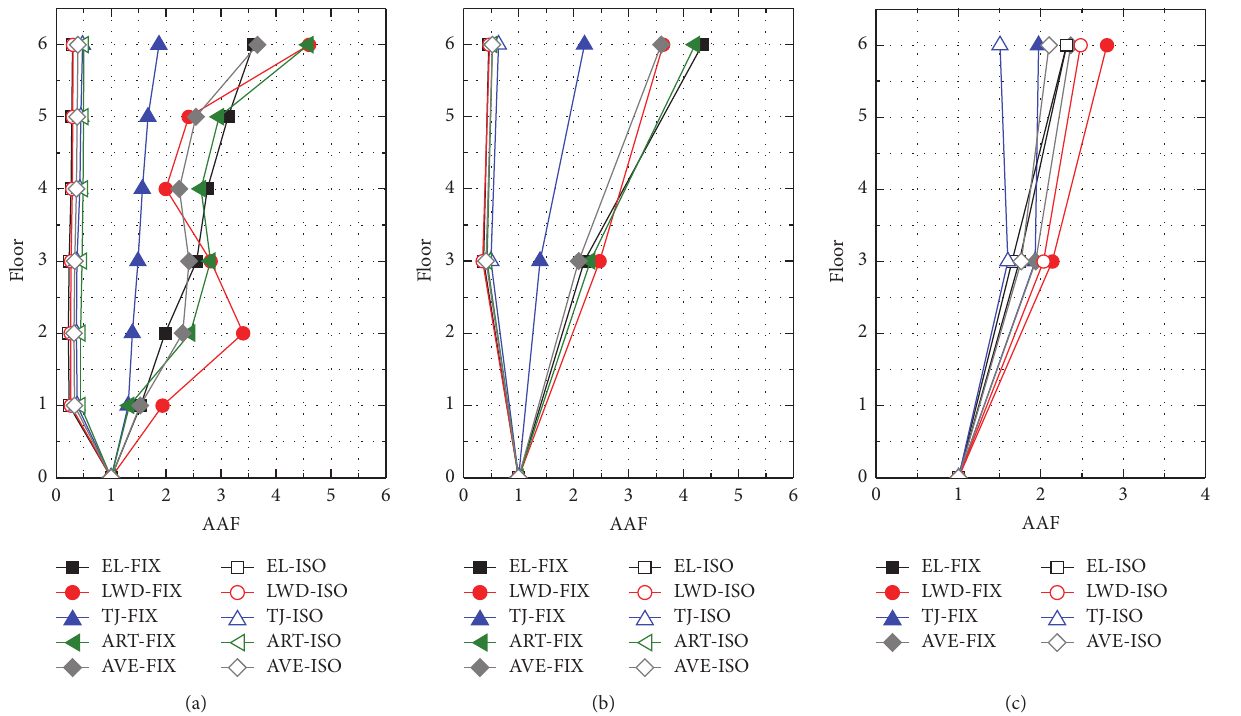
Figure 14: Comparisons of AAF for the isolated and fixed structures under moderate earthquakes: (a) direction x ; (b) direction y ; and (c) direction z